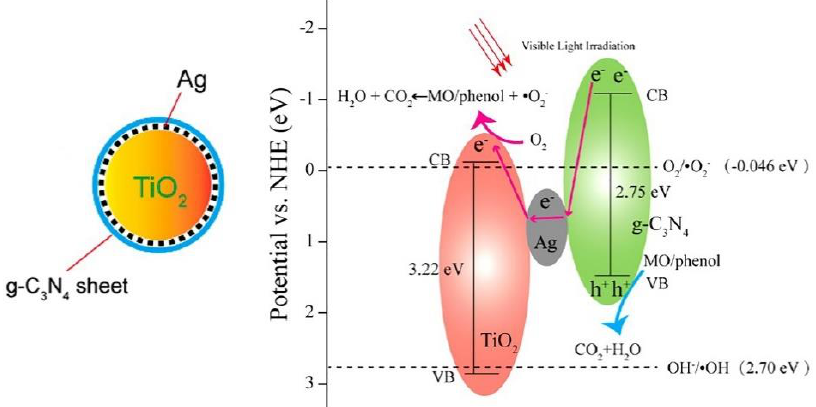
Figure 14. Photocatalytic mechanism scheme of g-C 3 N 4 /Ag/TiO 2 microspheres under visible light irradiation (>420 nm). Reprinted with permission from [108]. Copyright 2014, American Chemical Society.